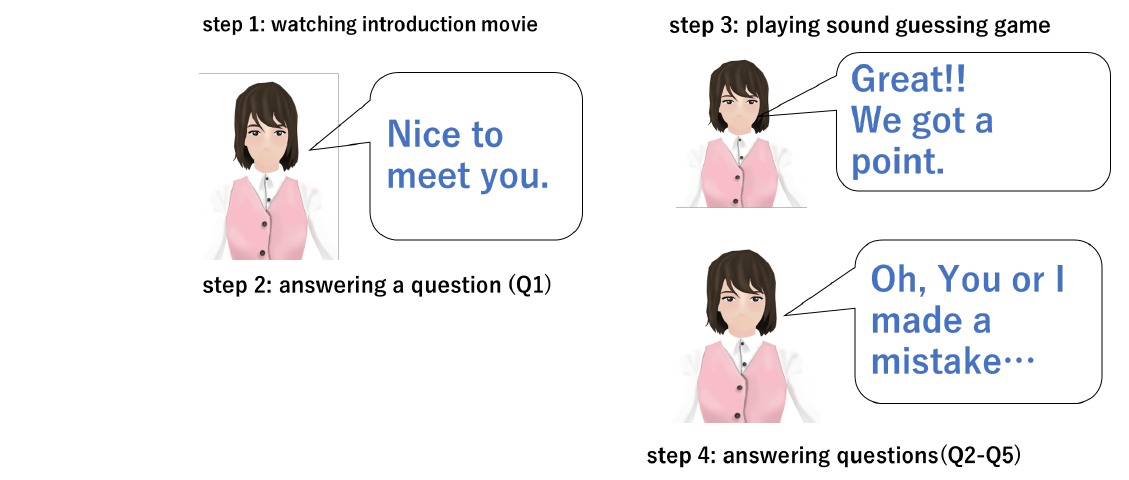
Figure 2. What participants did in the